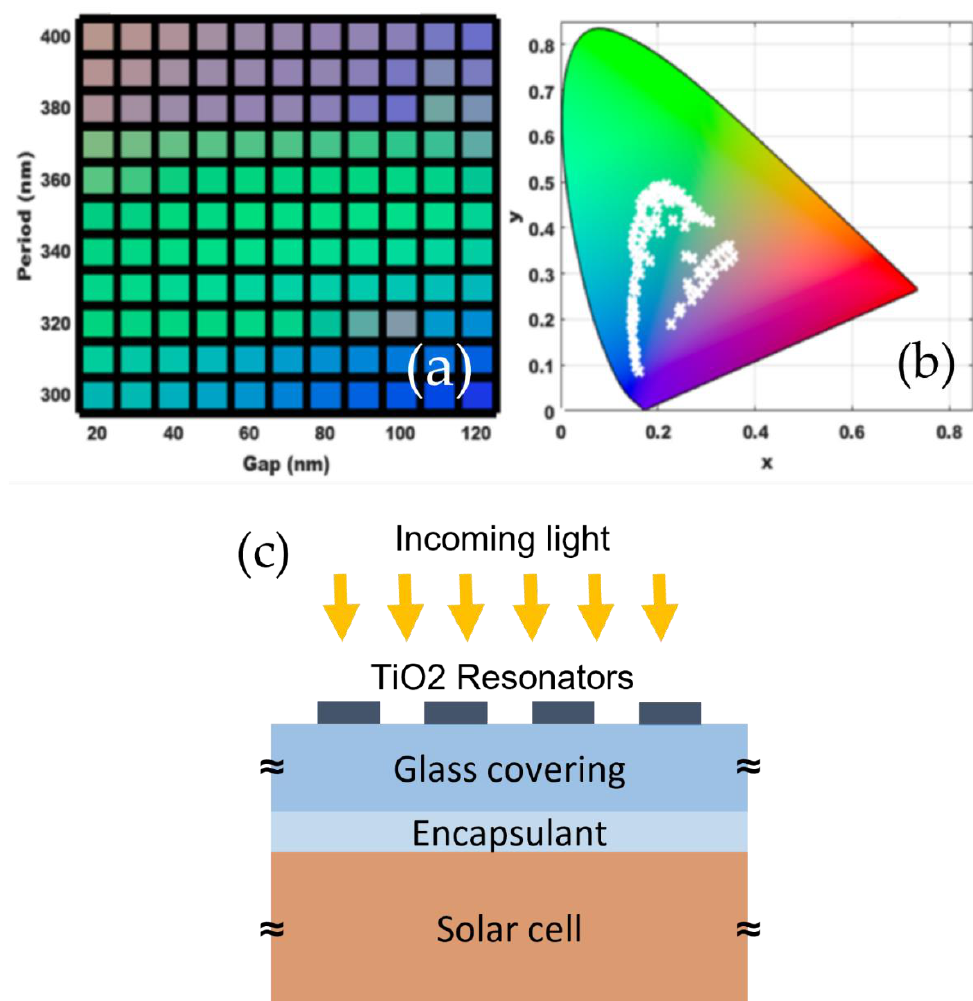
Figure 4. ( a ) Color palette generated from TiO 2 disk resonators (on silica substrate) of height 200 nm for different combinations of array period and gaps. ( b ) Corresponding positions of the colors on the CIE 1931 chromaticity diagram. ( c ) A schematic describing the TiO 2 resonator array on the silica glass layer above an encapsulated layer on top of a solar cell. Note that, in the simulations, glass covering is considered as a semi-infinite substrate. In this case, the light is incident from the air (n = 1) medium.